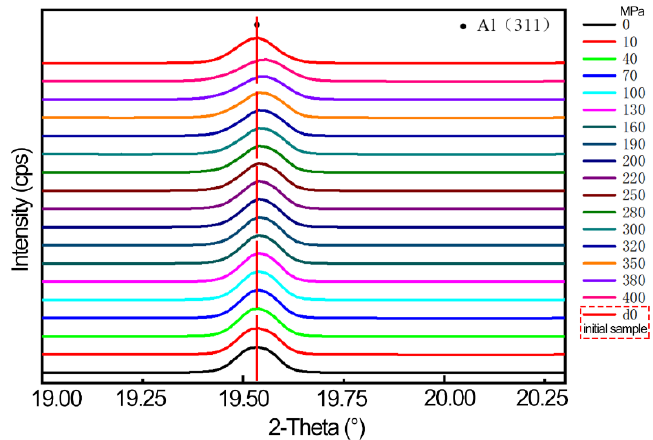
Figure 3. Diffraction integral maps under different loads.